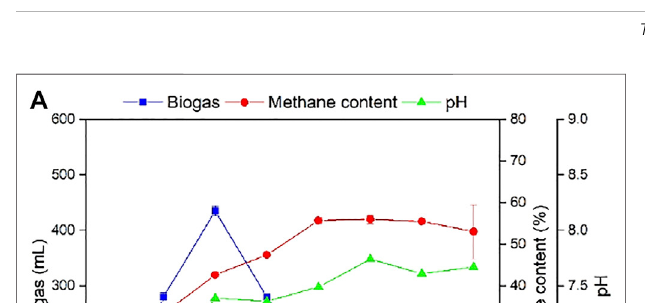
Frontiers in Environmental Science |